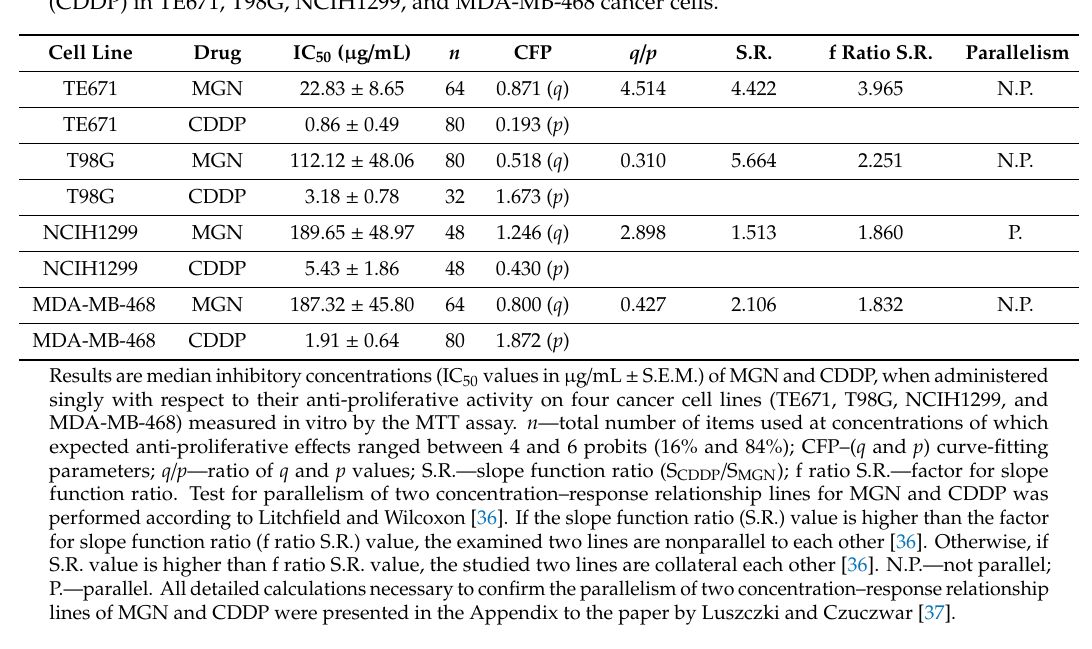
Table 1. Half-maximal inhibitory concentrations (IC 50 ) for the magnoflorine (MGN) and cisplatin (CDDP) in TE671, T98G, NCIH1299, and MDA-MB-468 cancer